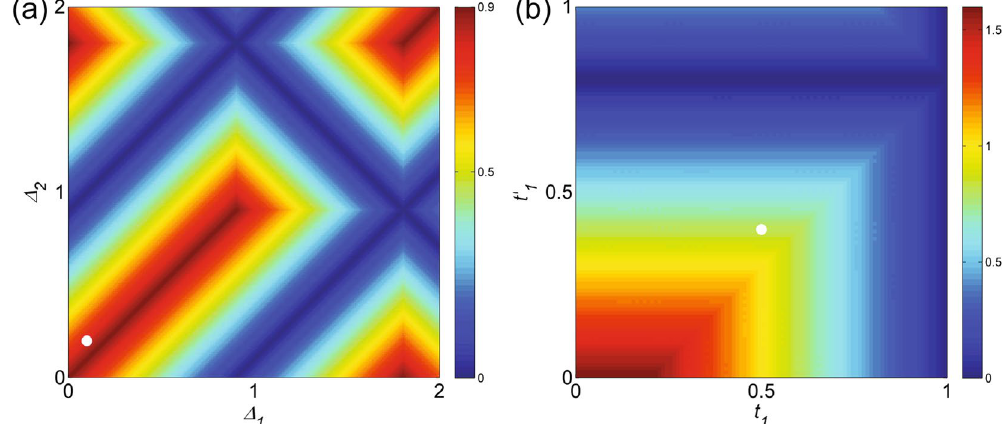
Figure 4. The gap for the case of two Majorana chains: ( a ) in the ( Δ 1 , Δ 2 ) plane; ( b ) in the ′ t t ( , ) parameters are t 1 = 0.5, t 2 = 1, ′ = − . ′ = − . t t 0 4, 0 8 , when the topological phase is with N = 0, N ′ = 2 and is 1 2 denoted by the white dots in the